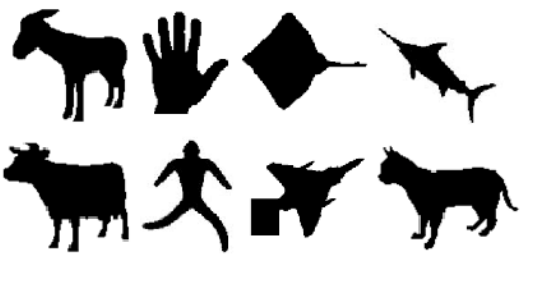
Figure 6. Image3 retievals using Hierarchical Centroids Descriptors